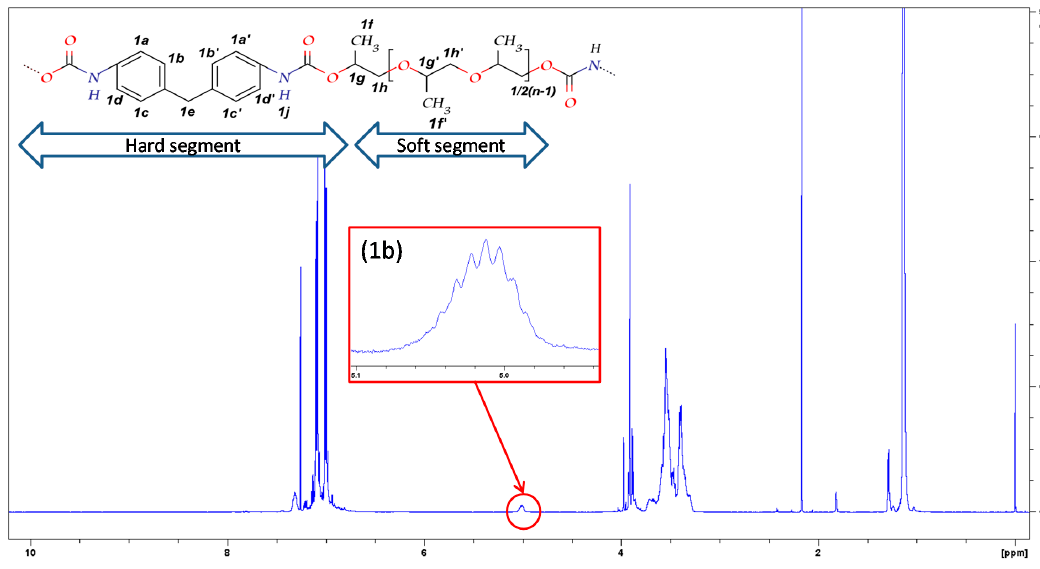
Figure 2. 1 H-NMR spectra of the blank sample UP 2 - O - 0 . The multiple peaks at 4.9–5.1 ppm range were enlarged and shown in Figure 2(1b).